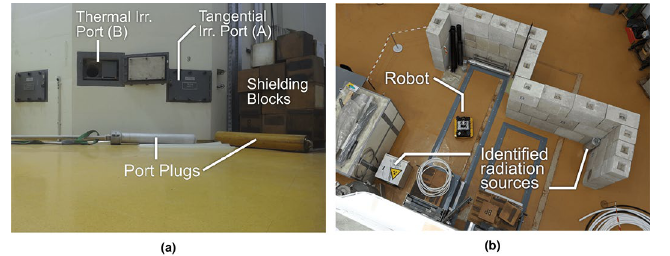
Figure 6. Photographs highlighting radiation sources in human restricted areas, ( a ) collected by the robot near an open irradiation port, and ( b ) discovered unknown sources (radionuclide storage container and irradiated heavy water canister). (Annotations included using Inkscape version 1.0.2 https:// inksc ape. org/ relea se/ inksc ape-1.